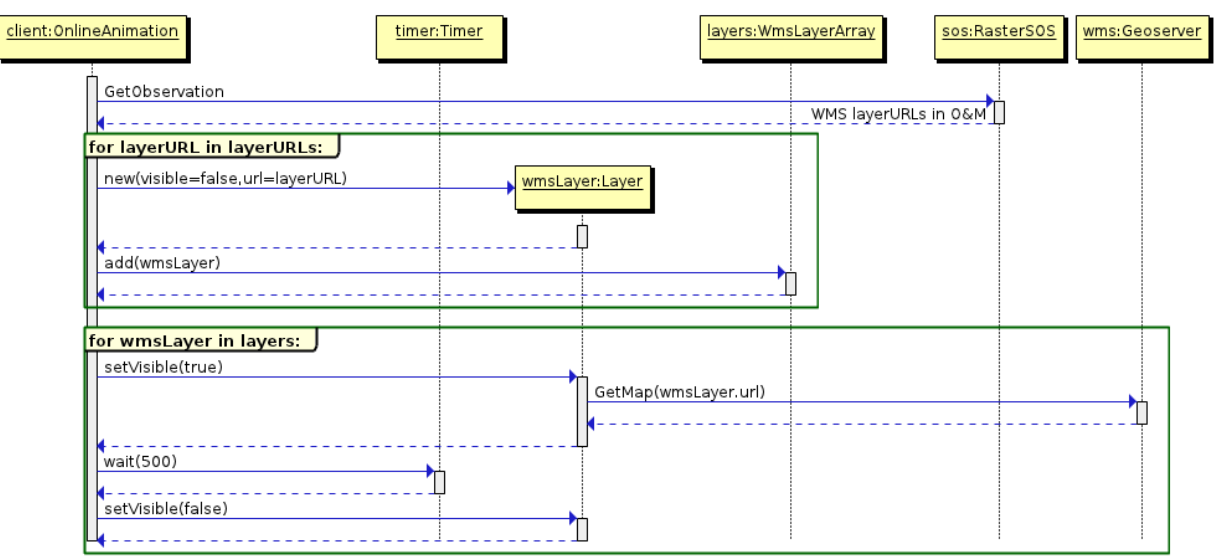
Figure 9. Screenshot of the web application visualizing the weather radar data.